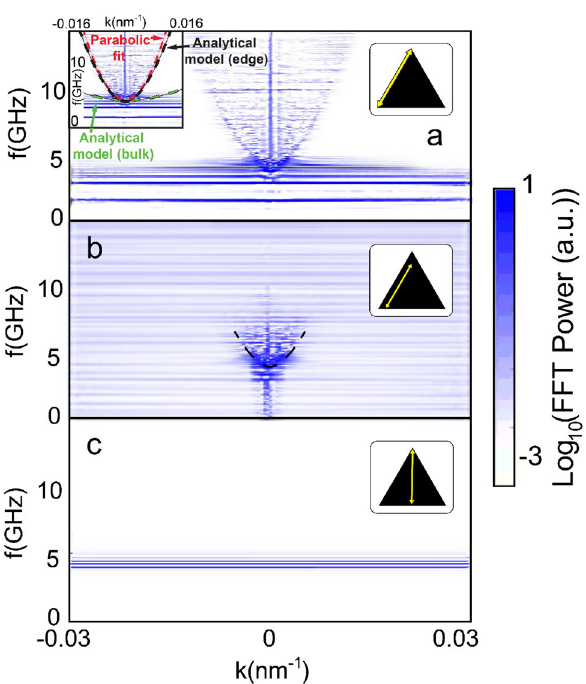
Fig. 4 Dispersion relation in a 49° angle aperture triangle for a the left edge of the triangle from the left vertex all the way to the top. Both dynamical regimes are represented in the chosen path: the low-frequency modes constant in frequency and the para- bolic ones, at higher frequencies. b The left side of the dot with a separation of ∼ 80 nm from the edge. Although noticeable, both mode regimes are less intense than in the case of the left edge analysis. The black dashed line indicates the less intense parabolic dispersion. c A straight line perpendicular to the base of the dot, separating it in two halves. In this particular case only the low-fre- quency modes are present. These results reveal a direct correlation between the low frequency modes and the top corner of the trian- gle, associated with the DW, and the parabolic mode with the edge of the